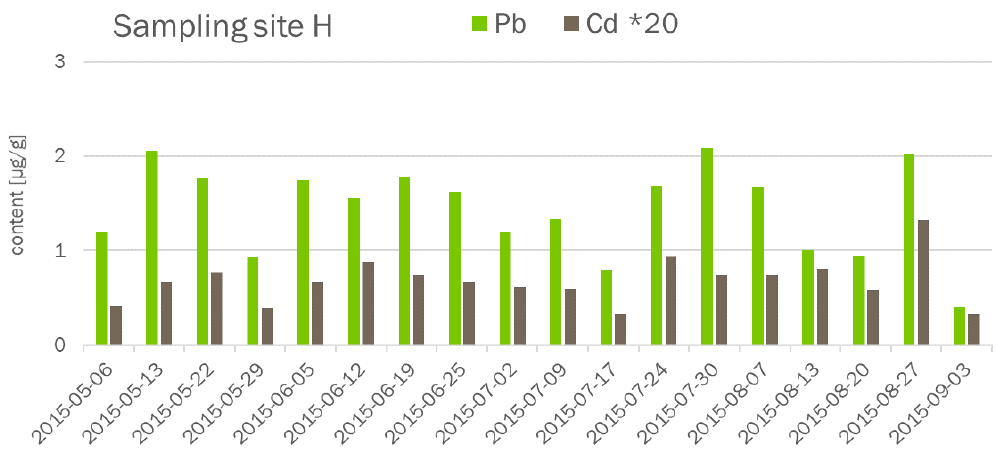
Figure 1. Contents of Cd and Pb in needles collected at sampling site H for the entire sampling period.